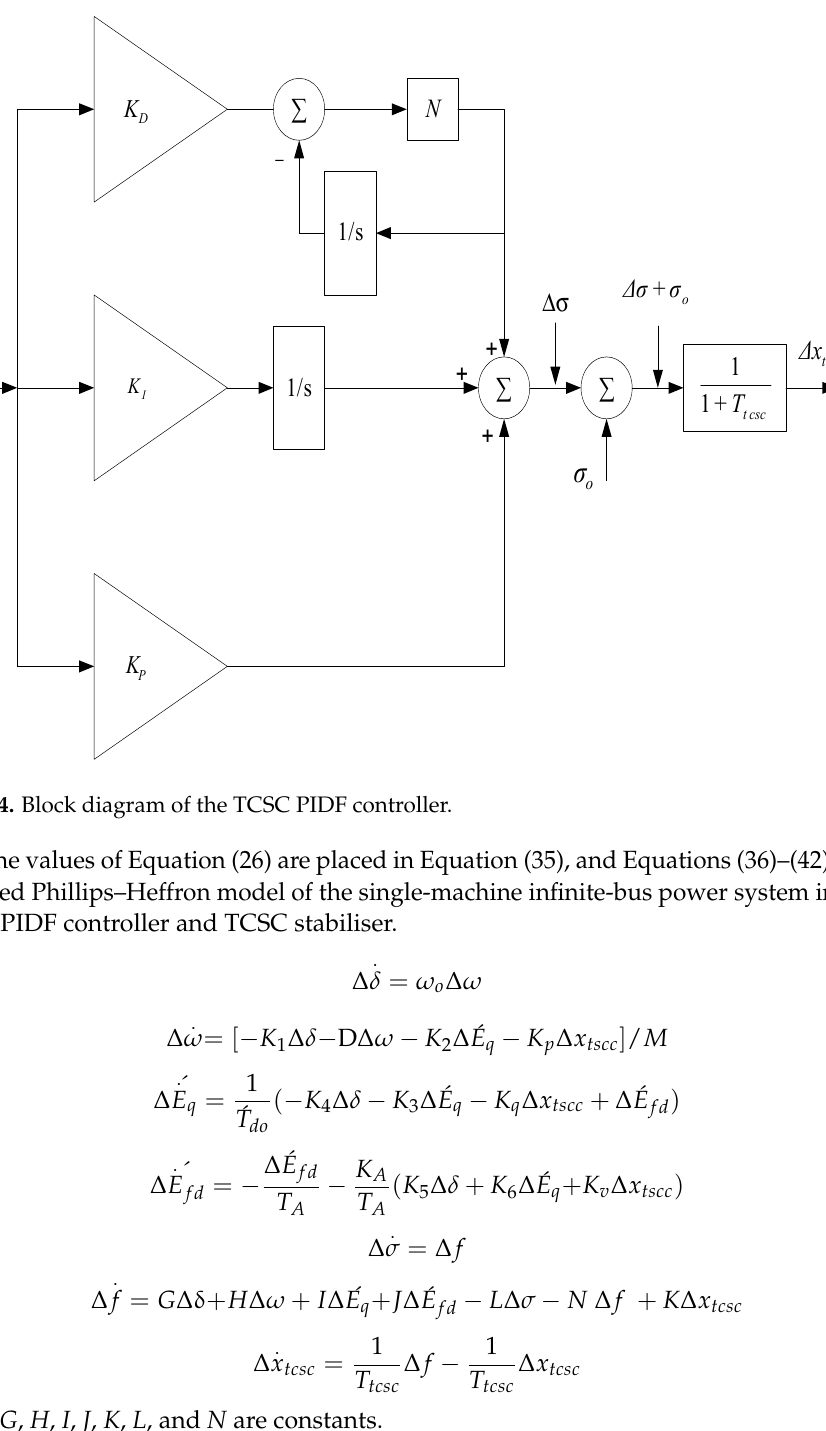
where G , H , I , J , K , L , and N are